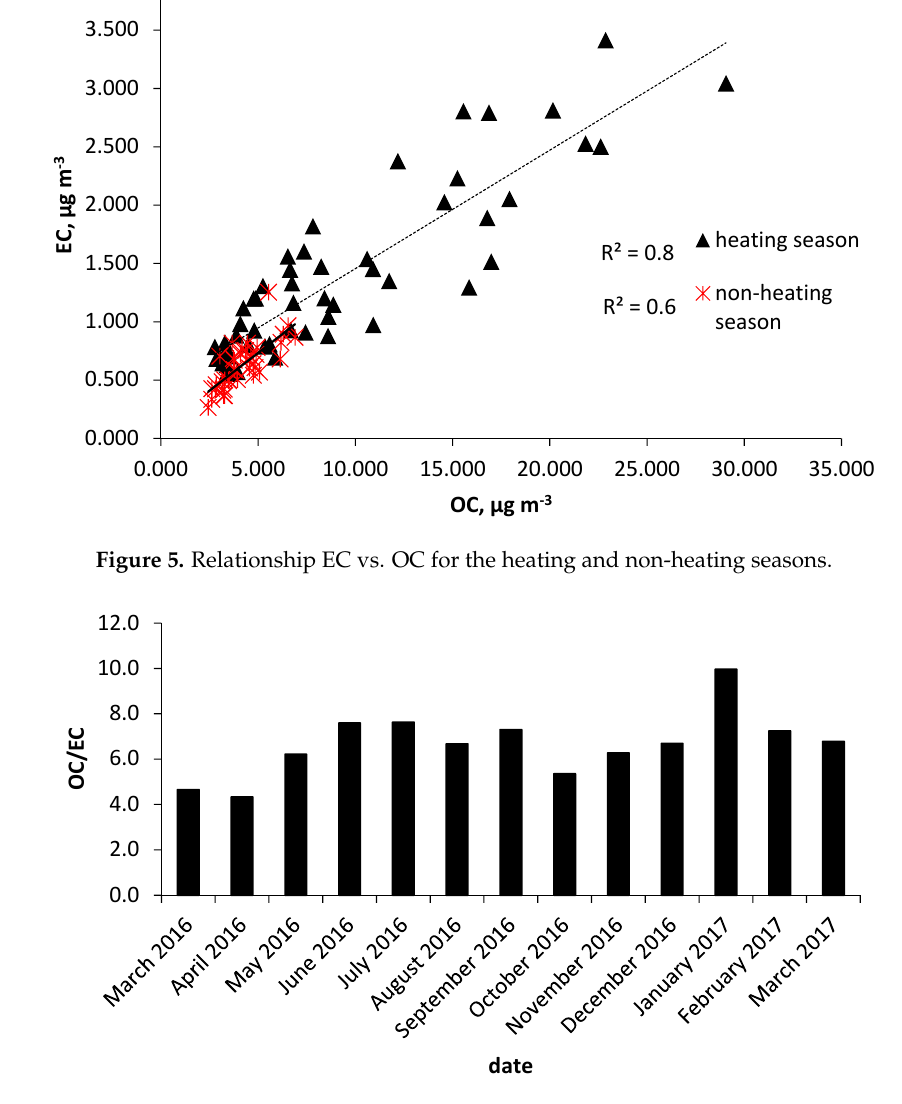
Figure 6. Monthly mean variation of the OC/EC ratio.